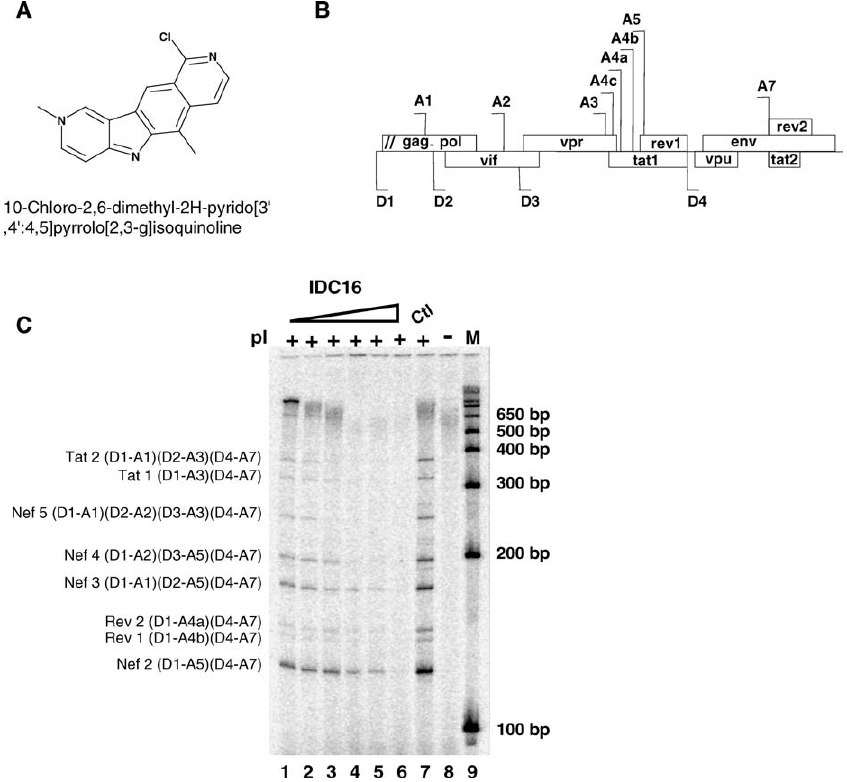
Figure 1. Selective Inhibition of HIV-1 RNA Splicing Ex Vivo by IDC16 (A) Drawing and formula of IDC16 compound. (B) Schematic representation of HIV-1 genome. The 5 9 splice sites (D1–D4) and 3 9 splice sites (A1–A7) are indicated. The various open reading frames are boxed. (C) HeLa cells transfected with the p D PSP construct were either untreated (lane 7) or treated with 0.05 l M, 0.1 l M, 0.5 l M, 1 l M, 2.5 l M, or 5 l M of compound IDC16 (lanes 1–6, respectively). Multiply spliced products of HIV-1 RNA were amplified by RT-PCR using the oligonucleotide primers BSS and SJ4.7A. The PCR products were analyzed by polyacrylamide gel electrophoresis after normalization with GAPDH (see Materials and Methods). Nomenclature of the RT-PCR products on the left of the panel is according to [30]. Size markers (in bp) are shown on the right of the panel (lane 9). RT- PCR from untransfected HeLa cells (lane 8). doi:10.1371/journal.ppat.0030159.g001 PLoS Pathogens |